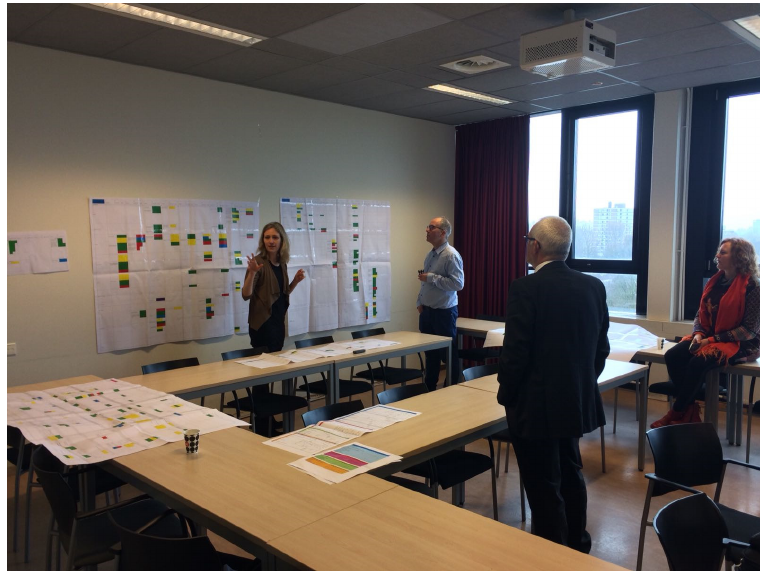
Figure 3. An analysis session with the entire research team (8 March 2018). Soc. Sci. 2021 , 10 , x FOR PEER REVIEW